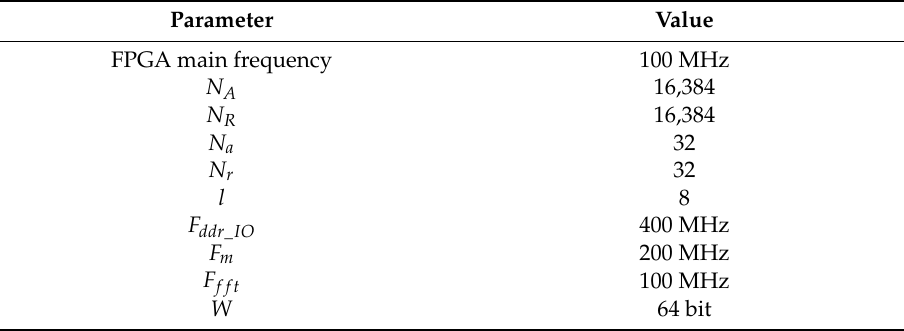
Table 3. Basic parameters of the single-node imaging implementation.